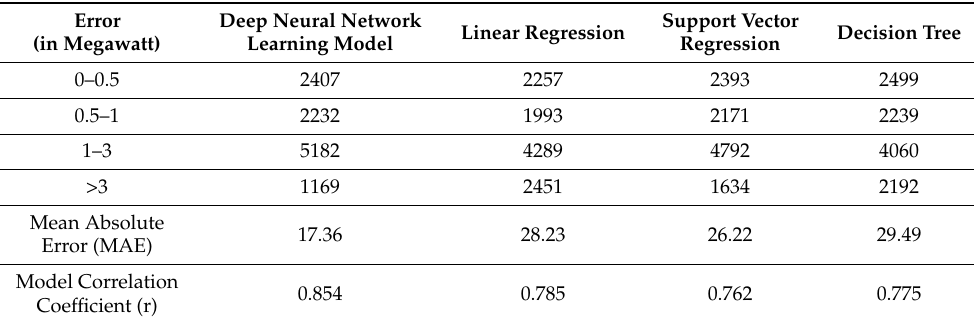
Table 7. The correlation of the absolute error dispersion for the deep learning (DL) and contrasting models